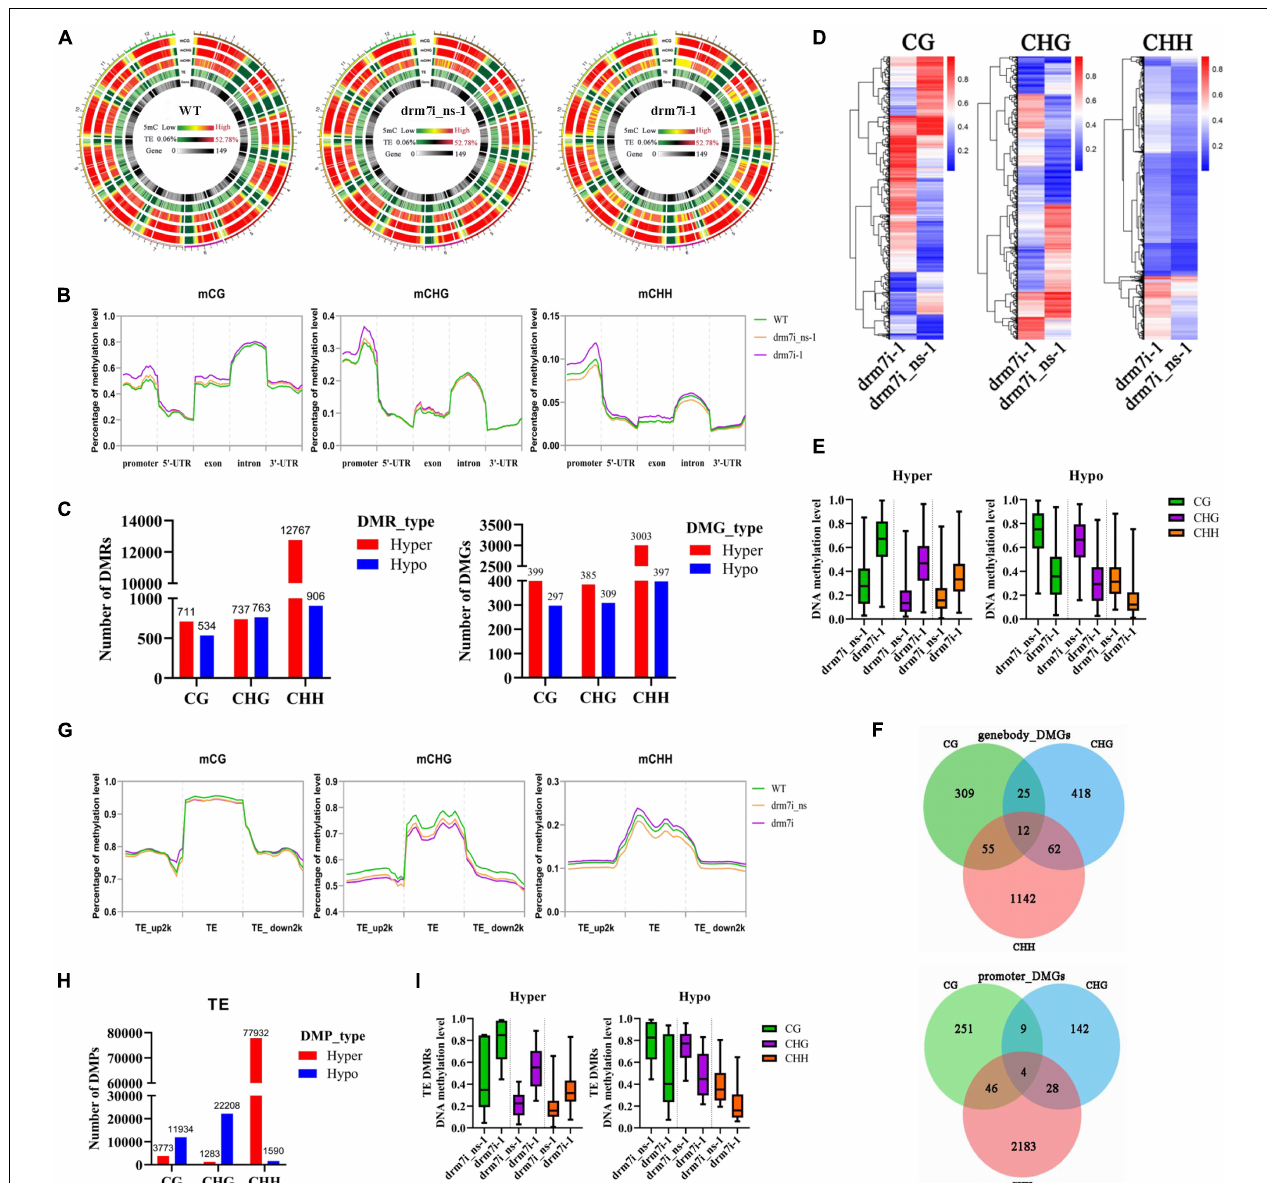
FIGURE 4 | Effect of SlDRM7 -RNAi on whole-genome DNA methylation. (A) Whole-genome bisulfite sequencing (WGBS) reveals DNA methylation profiles globally. Genome-wide methylations of 12 tomato chromosomes from WT, drm7i_ns-1, and drm7i-1 samples are illustrated in the m CG, m CHG, and m CHH contexts (where H is A, T, or C), and m C for TEs and genes. (B) Density plots of differential m CG, m CHG, and m CHH at the regions of the promoter, 5’-UTR, exon, intron, and 3’-UTR. Green, orange, and purple lines represent WT, drm7i_ns-1, and drm7i-1, respectively. (C) Numbers of differentially methylated regions (DMRs) and differentially methylated genes (DMGs) at CG, CHG, and CHH sites in drm7i vs. drm7i_ns. (D) Heat maps of the methylation level of DMRs at CG, CHG, and CHH sites in drm7i vs. drm7i_ns. (E) Overall DNA methylation level of hyper- and hypo-DMRs at CG, CHG, and CHH sites identified in drm7i_ns vs. drm7i. (F) Venn diagrams of DMGs associated with gene body (left) and promoter regions (right) in drm7i. (G) Density plots of differential mCG, mCHG, and mCHH at TEs and their 2-kb upstream and downstream regions. WT, drm7i_ns-1, and drm7i-1 are indicated. (H) Numbers of differentially methylated probes (DMPs) of TEs at CG, CHG, and CHH sites in drm7i-1 vs. drm7i_ns-1. (I) Methylation levels of hyper- and hypo-TEs in CG, CHG, and CHH